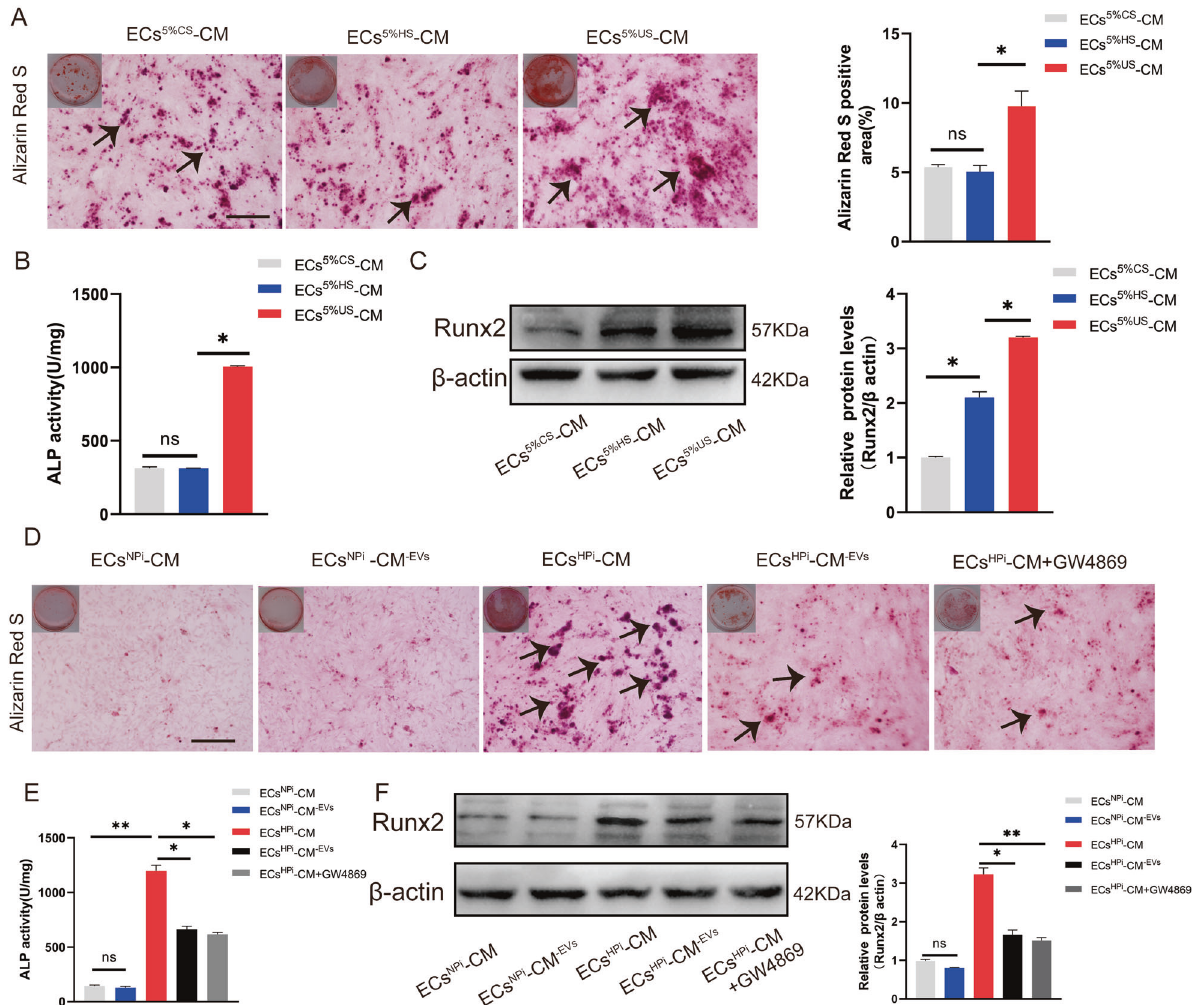
Fig. 1 The effect of ECs culture media on VSMCs calci fi cation. A – C 5% calf serum (CS), 5% healthy serum (HS), and 5% uremia serum (US) were supplemented to the culture media (CM) of mice ECs, respectively. These CM were collected for the following VSMCs cultures. Alizarin Red S staining ( A ), ALP activity ( B ), and Runx2 expression ( C ) were measured on day 14, day 7, and day 7, respectively. The black arrows indicate mineralized nodules in VSMCs. D – F VSMCs were cultured with 0.9 mM inorganic-induced endothelial CM (ECs NPi -CM), 3.5 mM inorganic phosphate-induced endothelial cells CM (ECs HPi -CM), and their EV-depleted conditional media (ECs HPi -CM -EVs , ECs HPi -CM -EVs , and ECs HPi -CM -EVs + GW4869). Alizarin Red S staining ( D ), ALP activity ( E ), and Runx2 expression ( F ) were measured on day 14, day 7, and day 7, respectively (Scale bar = 100 μ m). Three independent experiments were performed, and representative data were shown. Data are shown as mean ± SD. ns: no signi fi cance, * p < 0.05, ** p <